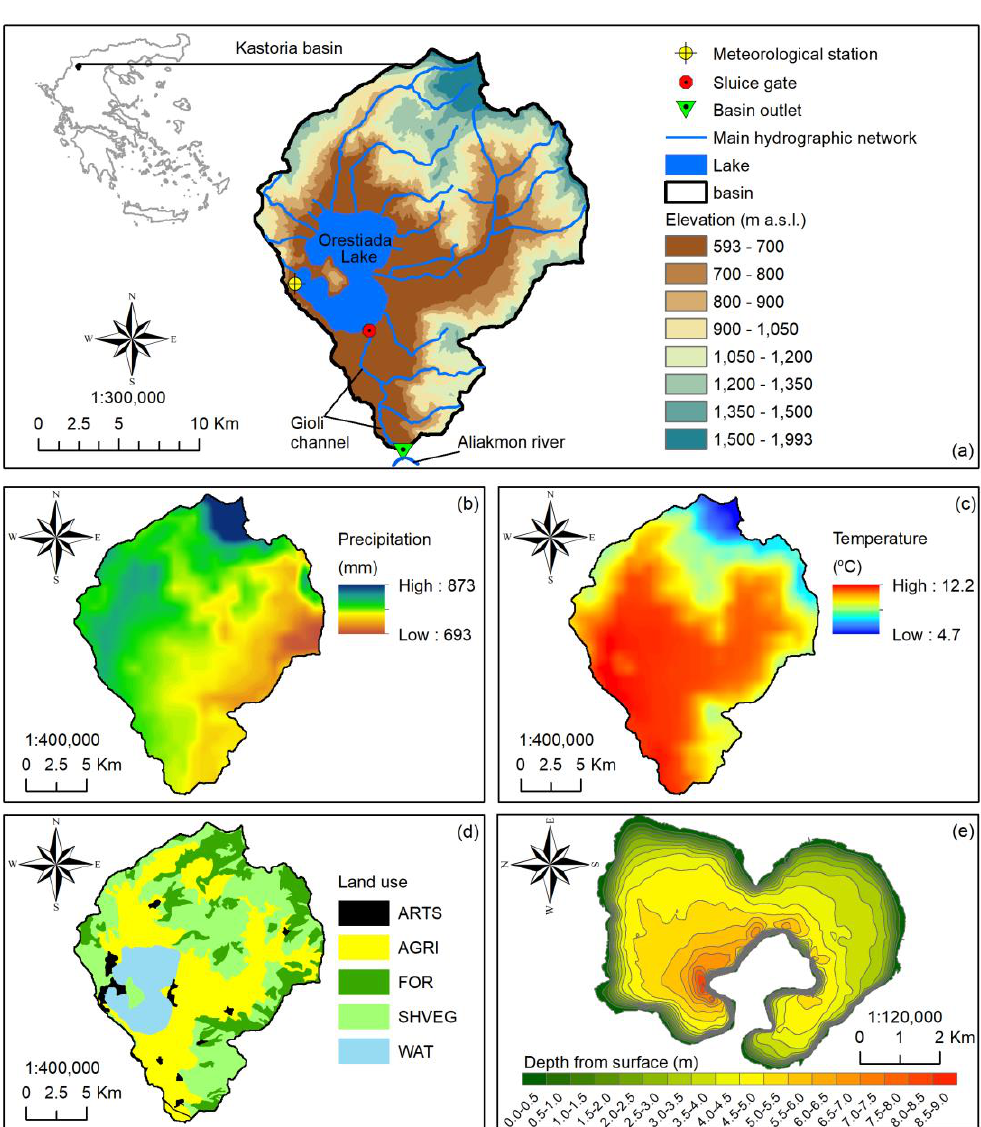
Figure 1. ( a ) The study area of Kastoria basin and Orestiada Lake, ( b ) and ( c ) spatial variation of mean annual precipitation and temperature, respectively, ( d ) main land uses, and ( e ) bathymetry of Orestiada Lake (0 depth corresponds to 628.00 m a.s.l.).